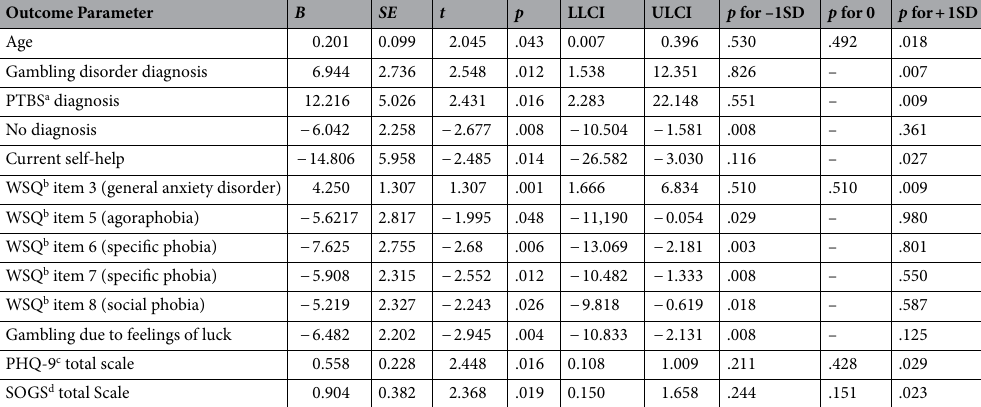
Table 6. Moderators for problem gambling improvement (Pathological Gambling Adaptation of Yale-Brown Obsessive Compulsive Scale–total difference scores, means are centered); results of intention-to-treat sample ( N = 150). B = beta coefficient, SE = standard error; LLCI = lower limit confidence interval; ULCI = upper limit confidence interval; a PTBS = post-traumatic stress disorder; b WSQ = Web Screening